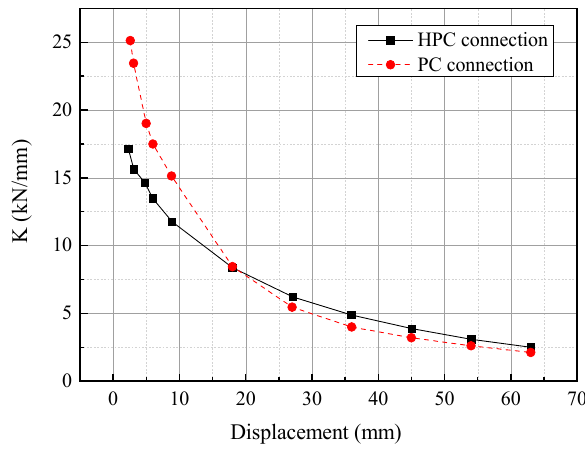
Figure 12. Curves for the stiffness degradation.